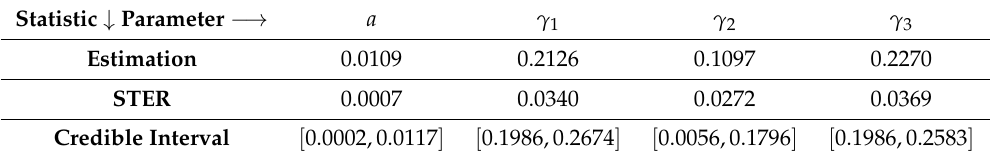
Table 7. The Bayesian estimation (BSE) for the BBXEx distribution using data set